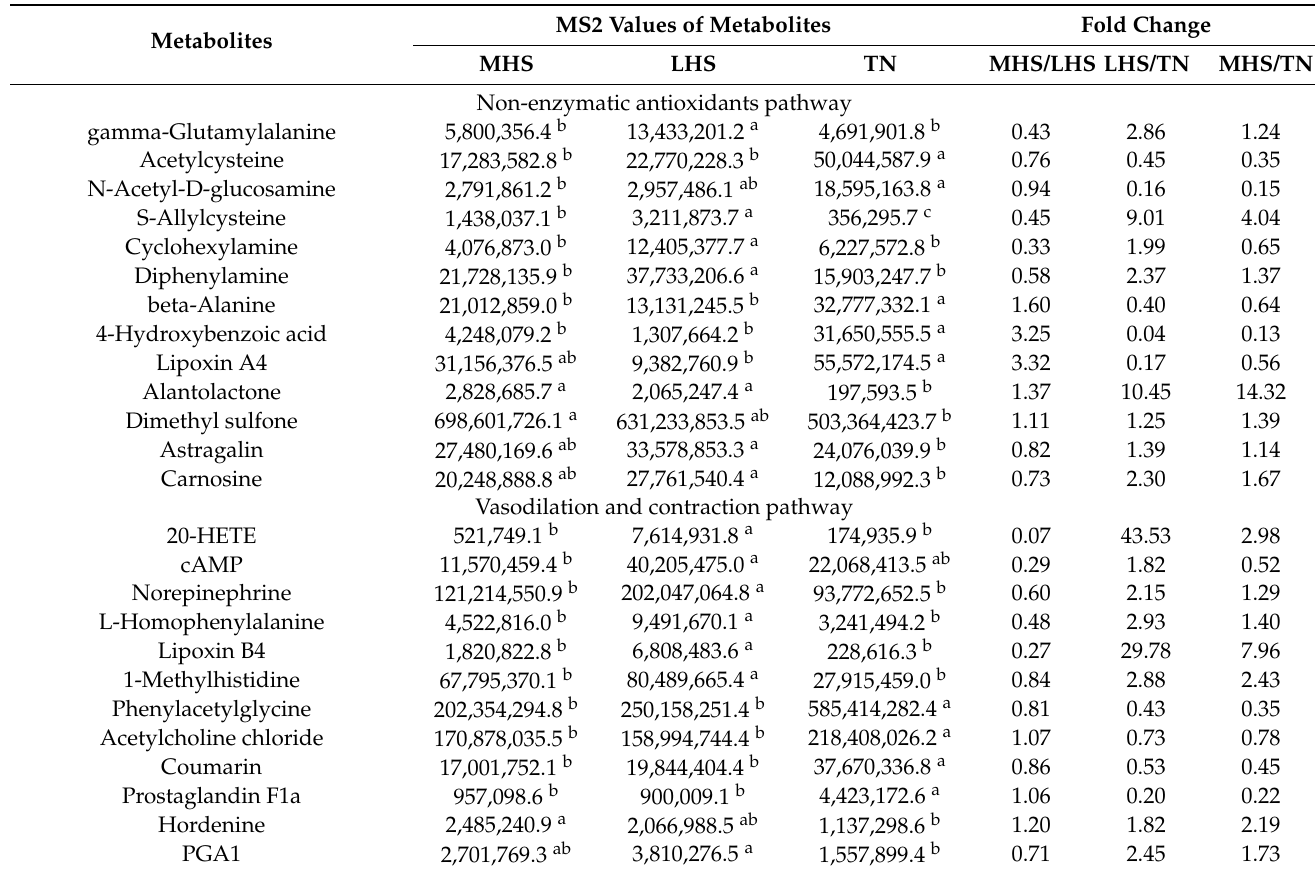
Table 5. Distinct plasma metabolites relating to non-enzymatic antioxidants and